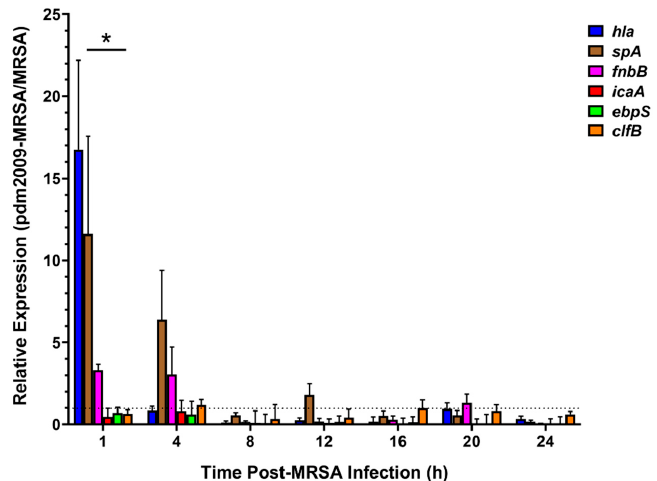
Figure 4. pdm2009-MRSA co-infection alters bacterial virulence factor expression in alveolar epithelial cells as compared to MRSA infection alone. MRSA virulence factor expression fold change values for co-infected samples relative to MRSA-alone-infected cells. Error bars represent SEM calculated from at least three biological replicates. Relative expression fold changes represent pdm2009-MRSA vs. MRSA infection alone and were calculated by the 2 − ∆∆ CT method. Comparison between groups was assessed by two-way ANOVA and significance testing by Tukey’s test, * p <